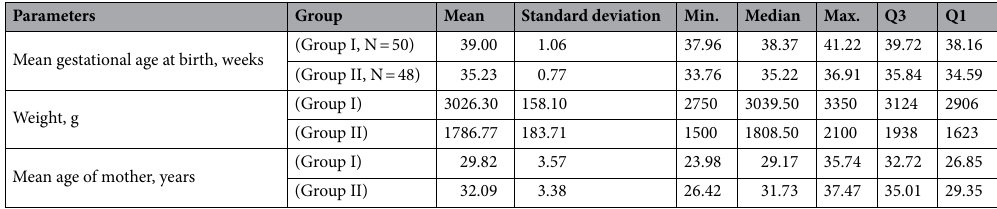
Table 1. Characteristics of newborns in groups I and